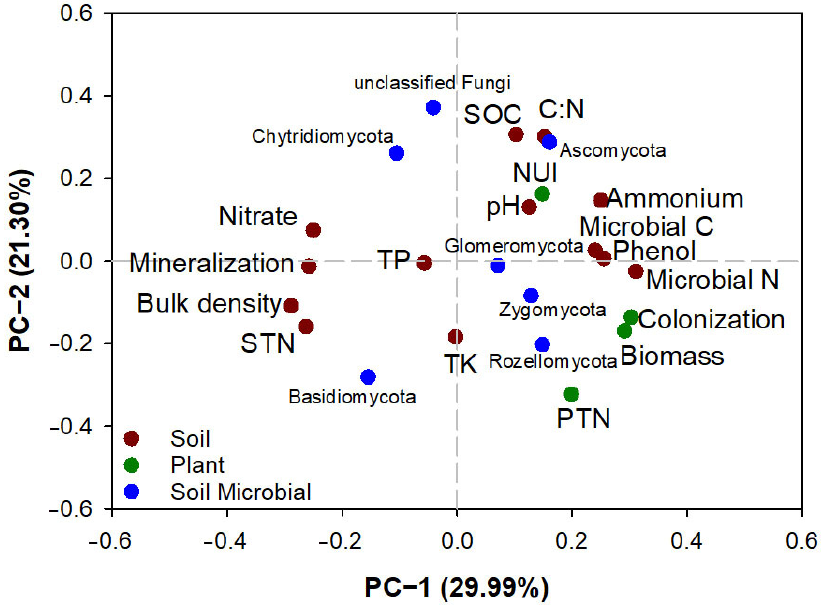
Figure 6. Principal component (PC) analysis of soil and plant parameters in communities dominated by Ledum palustre and Vaccinium uliginosum in the interruption treatment of dominant species re- moval and an untreated control of both species co-existing. Parameters enclosed in red circles indi- cate negative relationships and those in cyan circles show positive. Spots in dark red mark soil phys- icochemical properties: Nitrate, soil nitrate N content; Mineralization, net mineralization rate of my- corrhiza fungi; STN, soil total N content; Ammonium, soil ammonium N content; Microbial C, MBC; Microbial N, MBN; Phenol, soil phenol content; TP, soil total phosphorus content; TK, soil total potassium content; C/N, ratio of soil SOC to SON contents. Spots in dark green mark plant param- eters: PTN, plant total N content; Colonization, root colonization rate. Spots in blue mark soil ericoid mycorrhiza abundances of microbial phyla. 4. Discussion 4.1. N Availabilities in Two Communities with Contrasting Soil Chemicophysical Properties As local dwellers in boreal forested boglands, V. uliginosum and L. palustre had natu- ral differences in N absorption in their dominant communities. In the context of global warming, V. uliginosum presented a lower foliar N concentration than L. palustre in con- trolled ambient stands [16]. However, in contrast, in highly controlled environments where air temperature was caused to rise to 1.3 °C, foliar N concentration was higher in V. uliginosum than in L. palustre [66]. In our study, the two species did not show a distinct difference in plant N content when both were subjected to the removal treatment. There- fore, temperature was unlikely the factor driving the distinct responses of the two species. This can be caused by the fact that stands where two types of communities were distrib- uted had a similar level of soil N availability. Even so, their soil characteristics were highly distinct from each other. Compared to soils in communities dominated by V. uliginosum , those by L. palustre showed higher mineral N availability at higher levels in mineralized N rate and ammo- nium and nitrate N contents. In addition, soil total N content was also higher in soils of L. palustre communities, where organic N was lower in response to higher BD. These find- ings together suggest a cooccurring process where a large proportion of soluble organic N was immobilized in soils inhabited by L. palustre . This speculation can be seen in an- other study conducted in a hardwood forest watershed in Alaska, USA, where L. palustre enhanced inorganic N immobilization [67]. Therein, the authors surmised that it was the